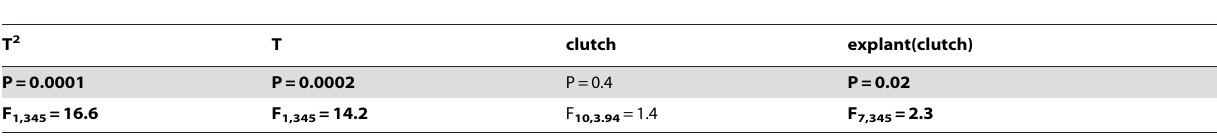
Table 4. ANCOVA table for endogenous F-actin contraction